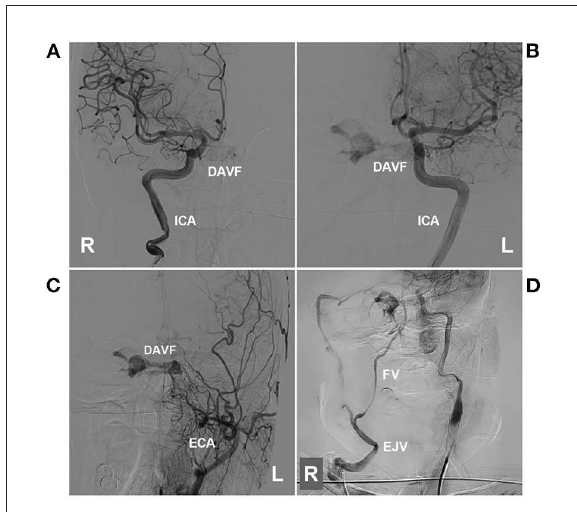
FIGURE8 Preoperative angiography of CS-DAVF embolized via the trans-EJV-FV-SOV route. (A, B) Angiographies of right (A) and left (B) ICAs show the dural branches of the ICA supplied to the DAVF. (C) Angiography of the left ECA shows the dural branches of the ECA supplied to the DAVF. (D) Venous phase angiography of the right ICA shows that the right FV served as the draining vein of the DAVF into the EJV. CS, cavernous sinus; DAVF, dural arteriovenous fistula; ECA, external carotid artery; EJV, external jugular vein; FV, facial vein; ICA, internal carotid artery; L, left; R, right; SOV, superior ophthalmic vein. FIGURE9